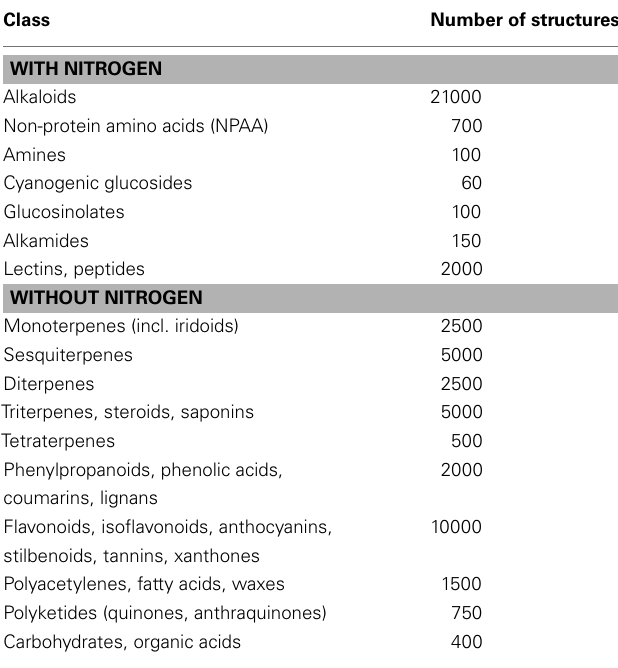
Table 1 | Structural types of secondary metabolites and known